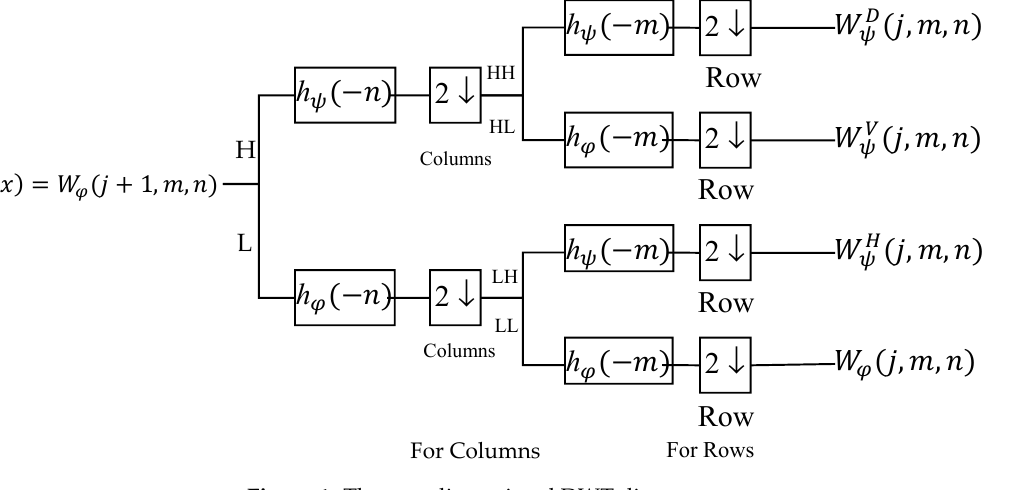
Figure 1. The two-dimensional DWT diagram.